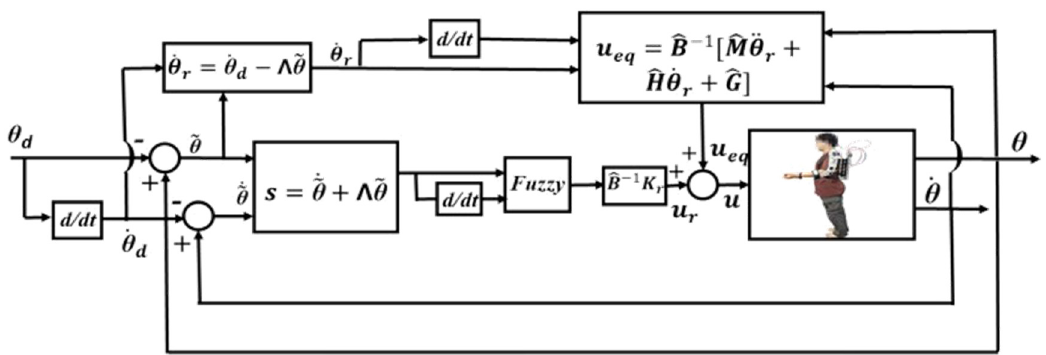
Figure 7. Configuration of the FSMC structure.